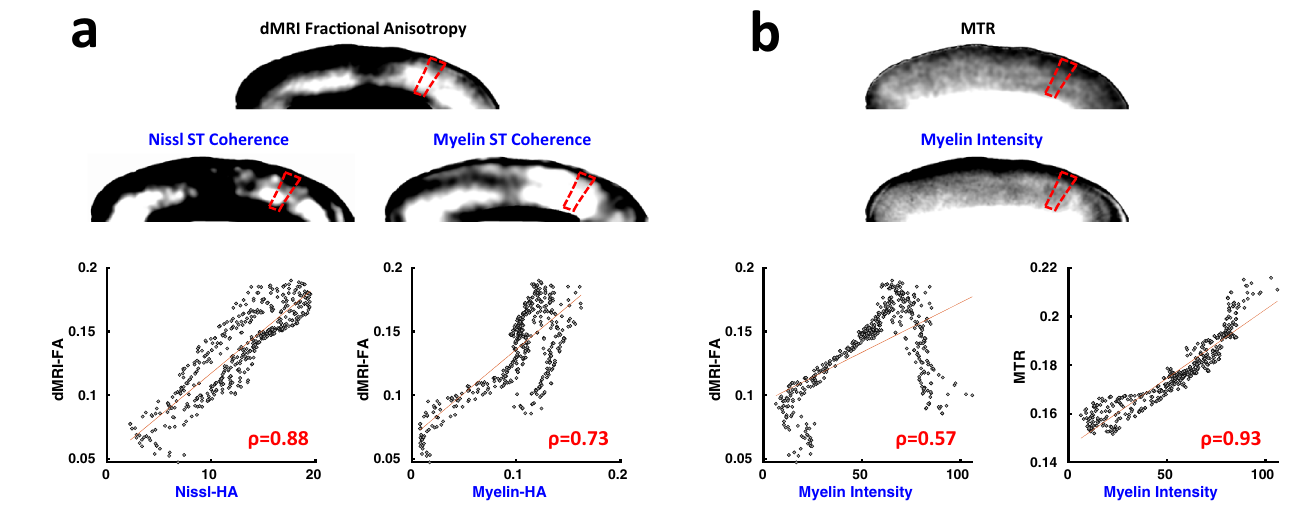
Fig. 3 | Example correlation of Histology and MRI variables sampled in columnar parcels. a Comparison of dMRI fractional anisotropy to corresponding Nissl-HAandMyelin-HAfrom one parcelof corresponding tissue. b Comparisonof magnetictransfer ratio(MTR) MRIcontrast with myelinintensity in same parcelas a . In both a and b , the top row depicts nonlinearly co-registered histology